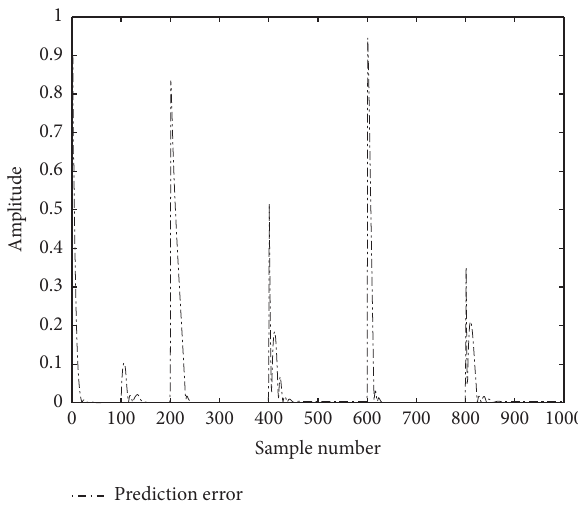
Figure 11: Tracking